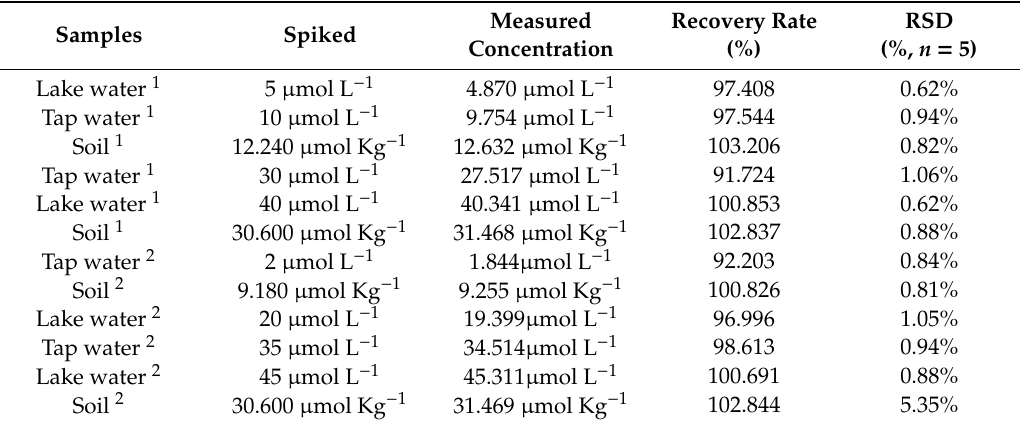
Table 2. Determination of OTC in environmental samples.